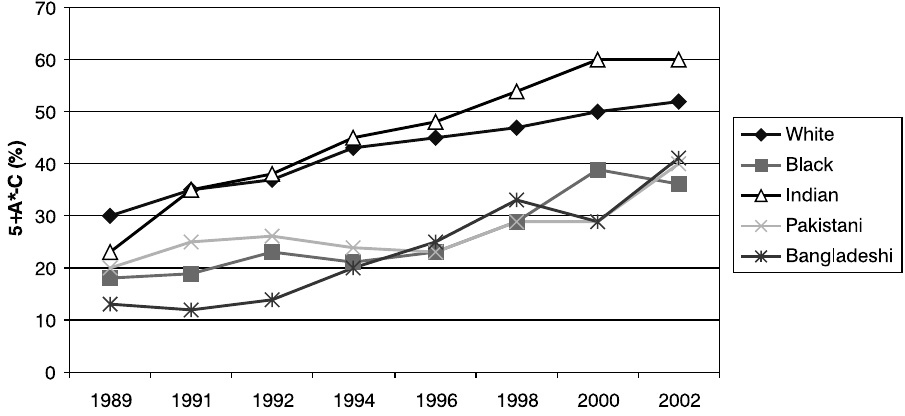
Figure 1. Changes in GCSE attainment by ethnicity in England and Wales, 1989–2002 (5+A*-C) Source : Youth Cohorts Study, Department for Education and Skills (2002) and Demack et al.